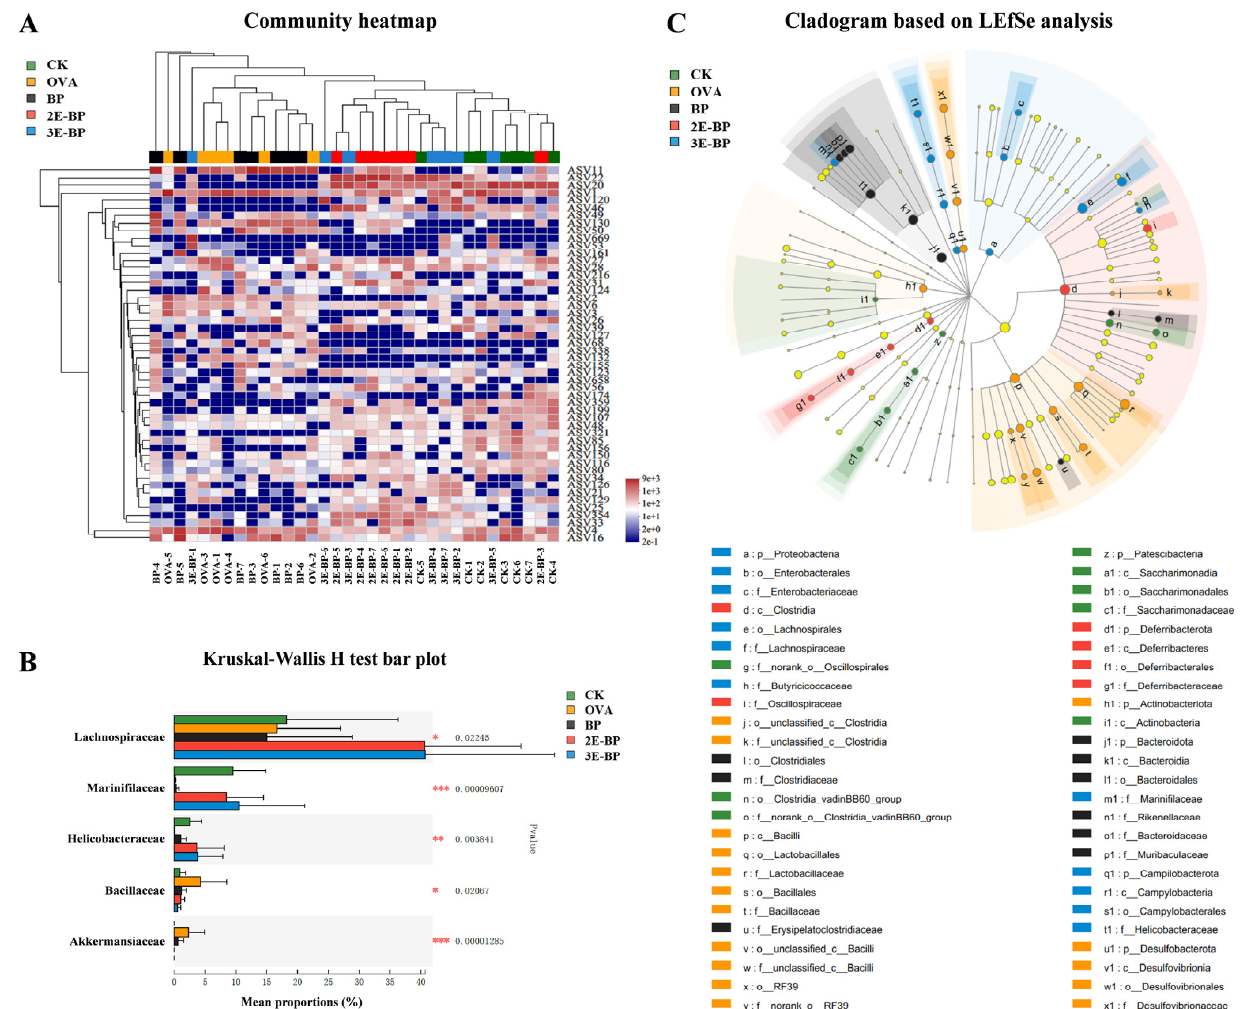
Figure 6. Heatmap analysis of gut microbiota community at ASV level ( A ). Kruskal–Wallis H test analysis of gut microbiota at family level ( B ). Cladogram based on LEfSe analysis of gut microbiota from phylum to class level ( C ). Asterisk * represents p < 0.05, ** represents p < 0.01, and *** depicts p < 0.001.